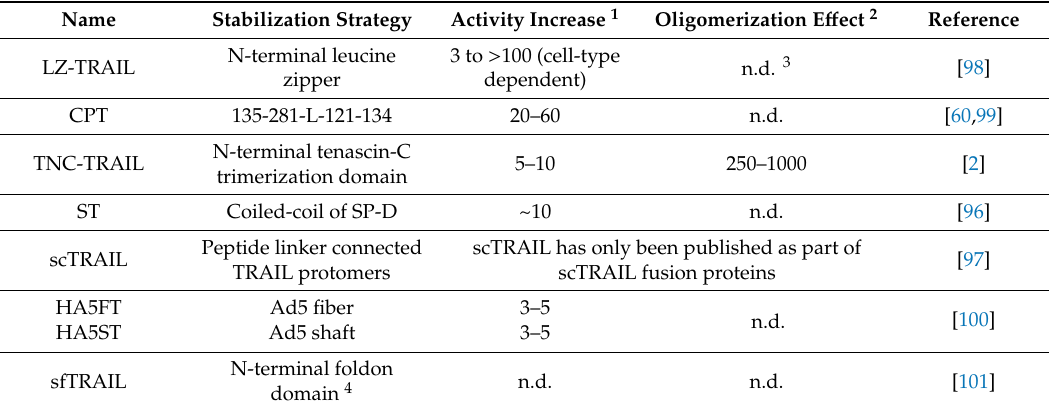
Table 3. Stabilized soluble TRAIL